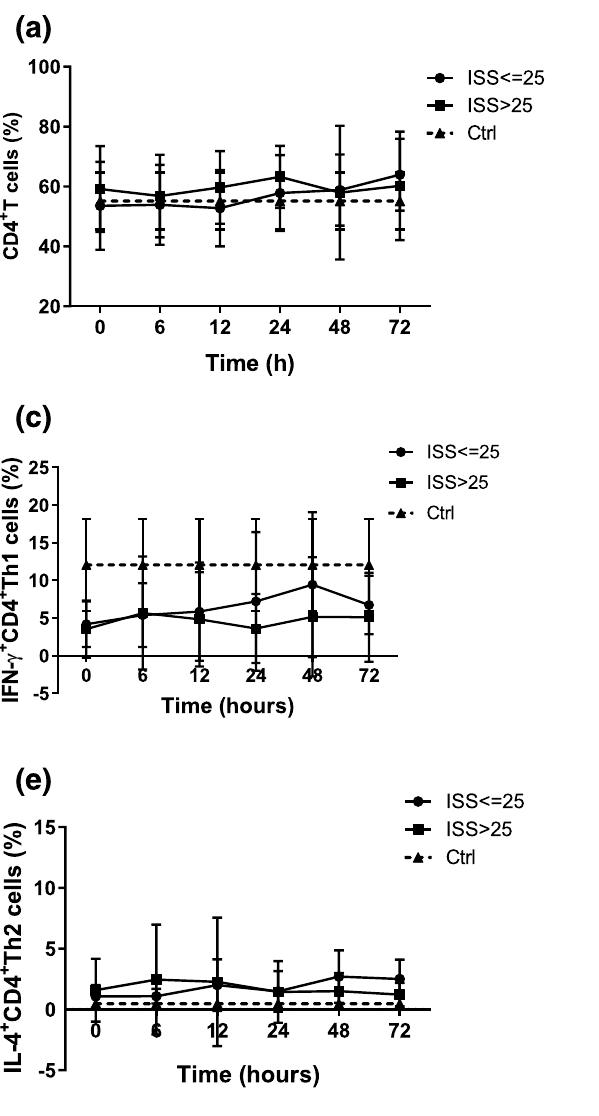
Figure 6. Trauma patients had CD4+ T suppression and shift to an anti-inflammatory Th2 phenotype. ( a ) CD4+ T cells in trauma patients grouped by ISS. ( b ) CD4+ T cells were more suppressed in the patient with a long ICU stay compared to those with a short ICU stay. ( c,d ) Trauma patients had suppressed IFN-γ production by CD4+ Th1 cells compared to the control group. ( e ) IL-4 production by CD4+ Th2 T cell in trauma patients grouped by ISS. ( f ) The patients with a long ICU stay had increased IL-4 production by CD4+ Th2 cells compared to those with a short ICU stay, * p <